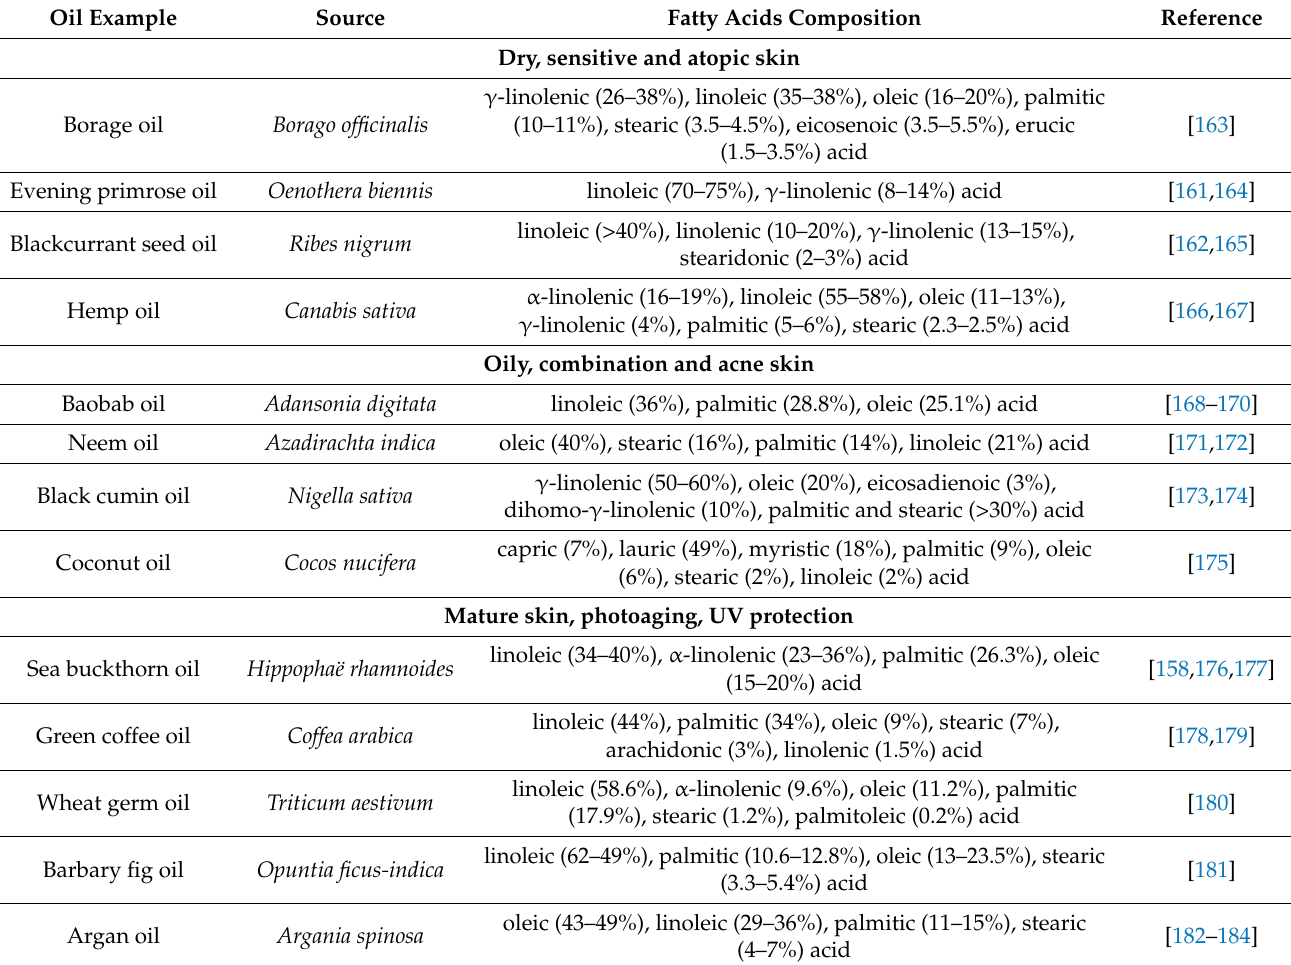
Table 2. Selected vegetable oils that are sources of fatty acids of importance for the